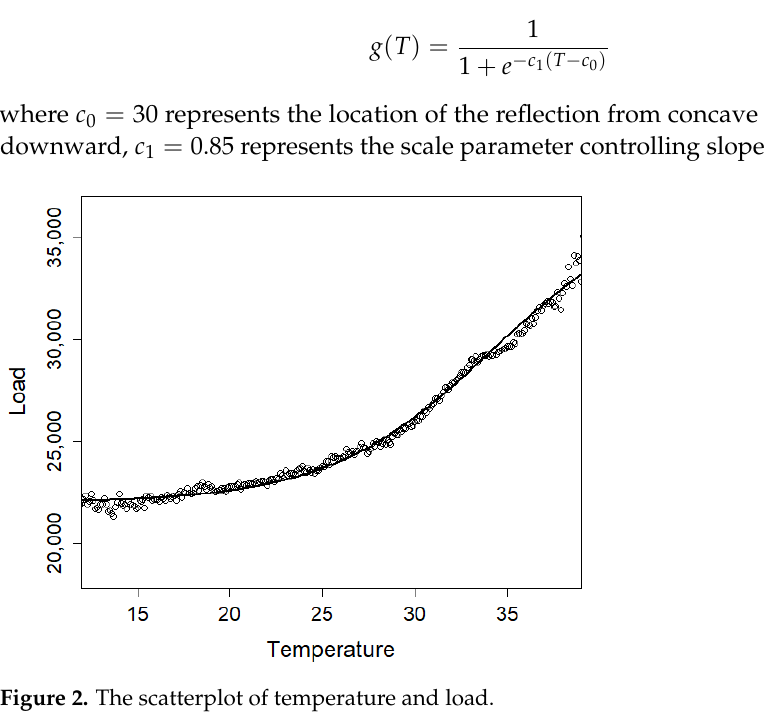
Figure 2. The scatterplot of temperature and